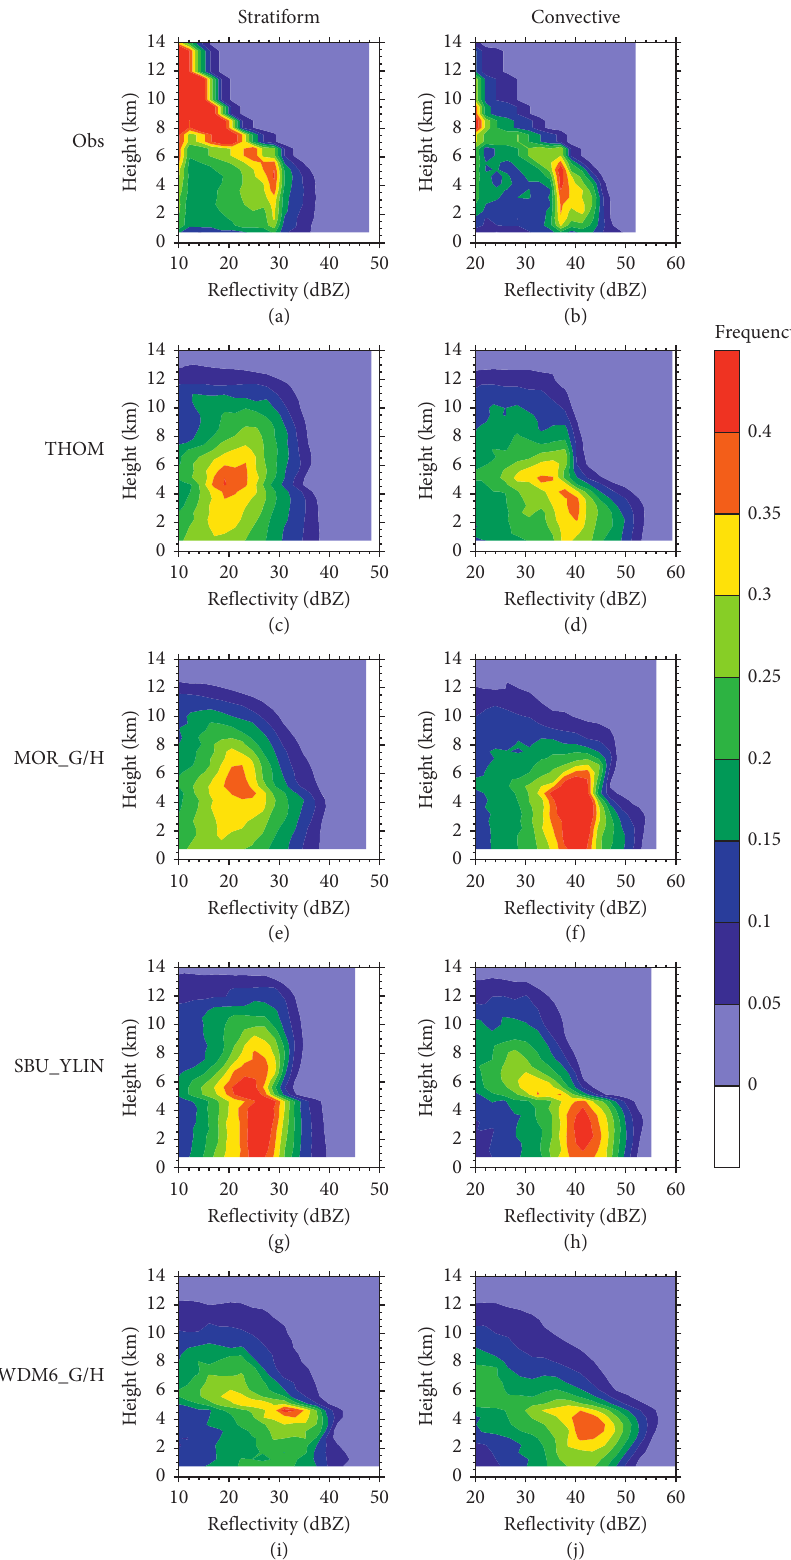
Figure 10: The Contoured Frequency by Altitude Diagrams (CFADs) of reflectivity over stratiform region (left column) and convective region (right column) for (a), (b) radar; (c), (d) THOM; (e), (f) MOR_G/H; (g), (h) SBU-YLIN; and (i), (j) WDM6_G/H. The analysis domain is shown in Figure